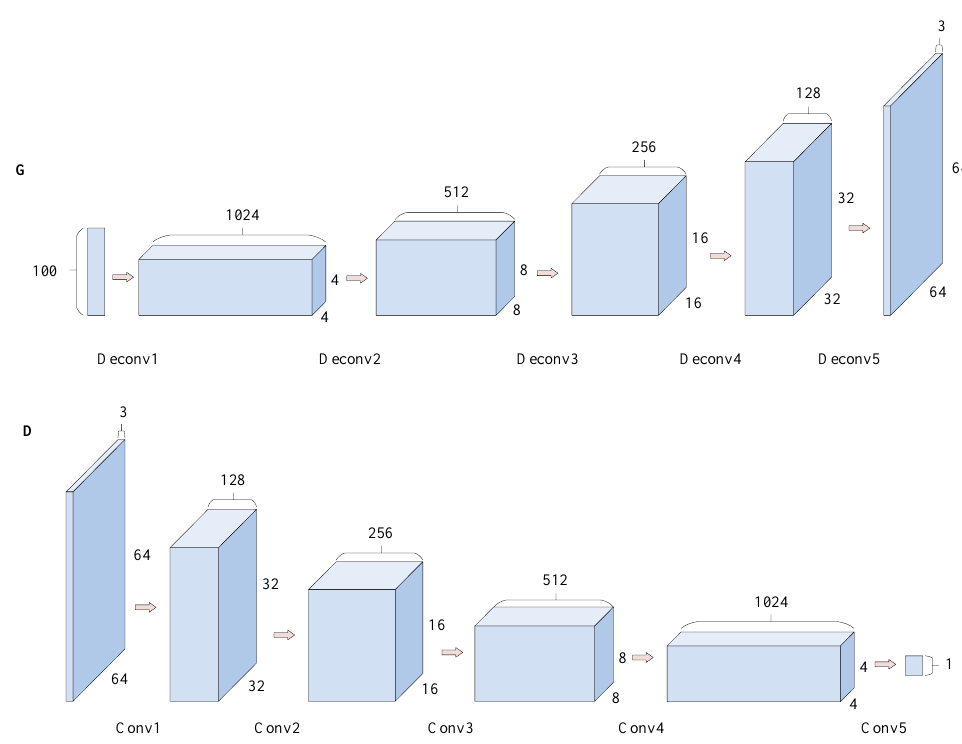
Figure 4. Schematic diagram of DCGAN. Here G denotes generator and D denotes discriminator.